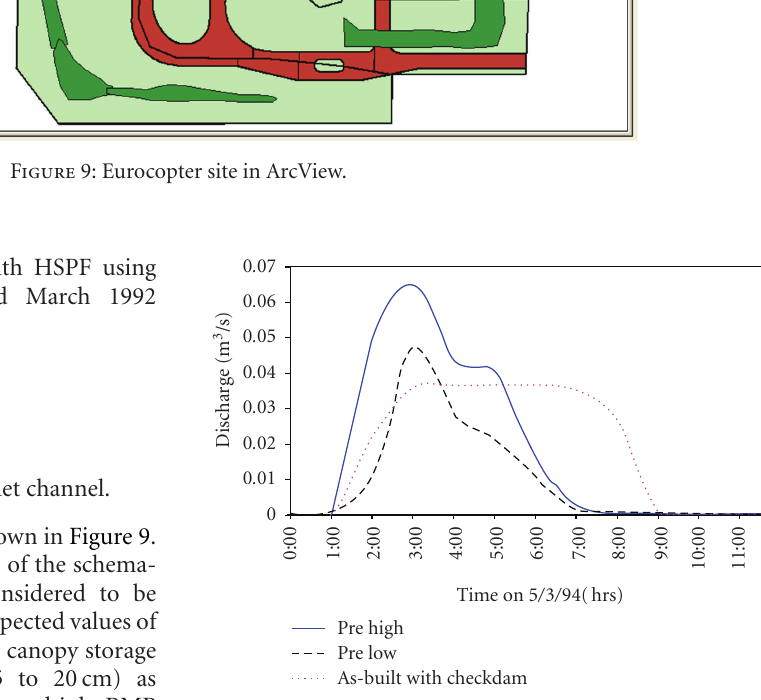
Figure 10: Comparison of HSPF model results for the Eurocopter predevelopment and as-built conditions with a check dam in the outlet